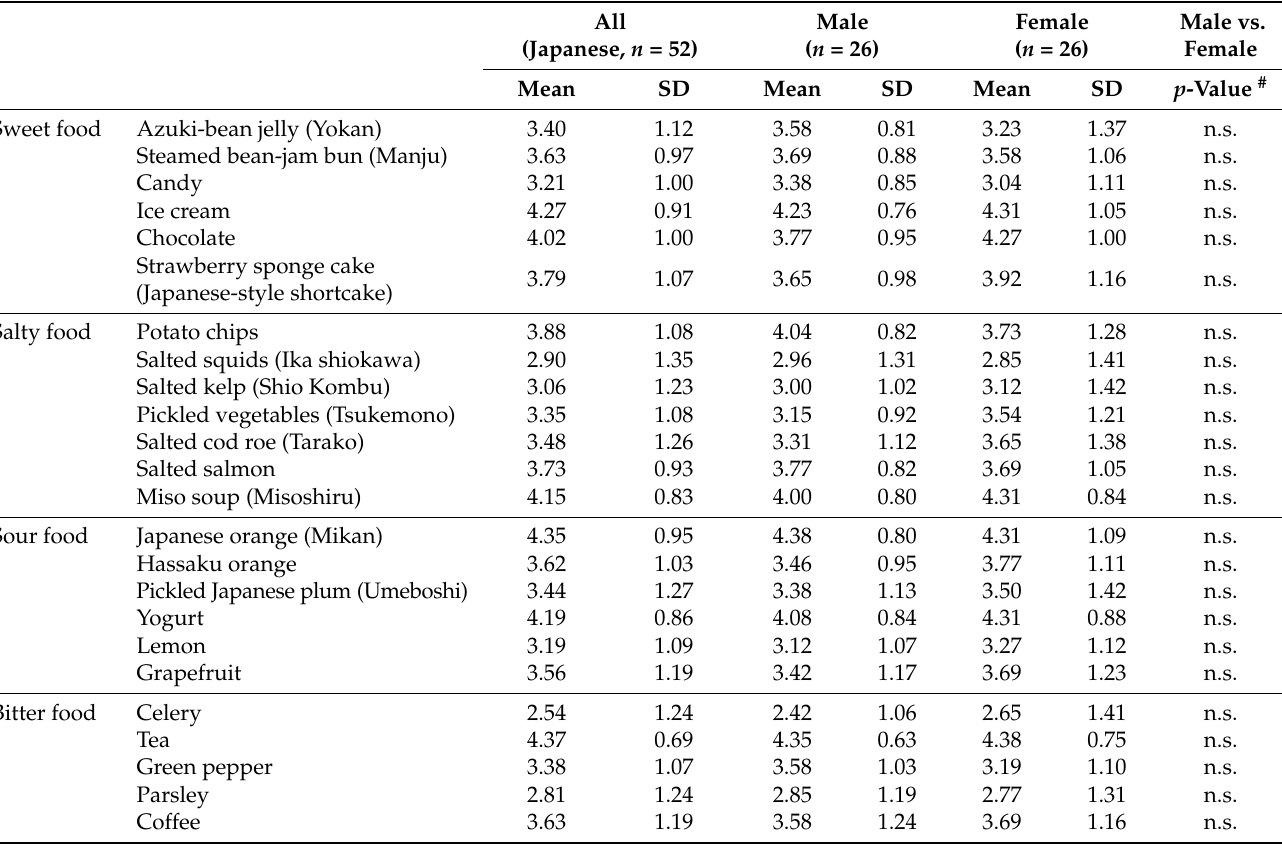
Table 2. Preferences of food in male and female subjects.